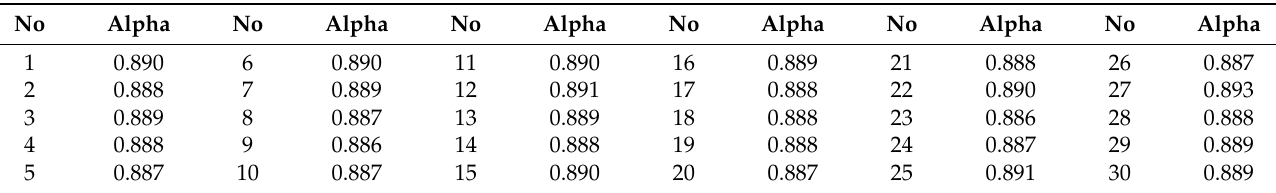
Table 2. Alpha values obtained when questions are removed.